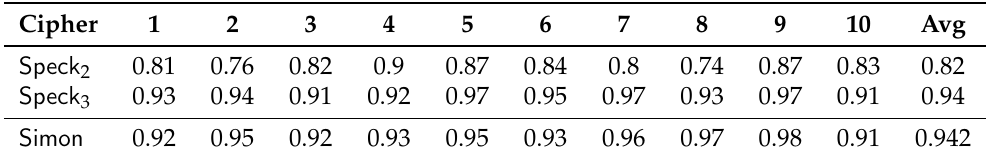
Figure 3. One-shot training and validation accuracy over epochs, for Speck , with a binary cross entropy loss. ( a ) With 200 samples, test accuracy 83%. ( b ) With 300 samples, test accuracy 91%. Table 1. One-shot test accuracies with a binary cross-entropy loss, Speck n indicates “on Speck dataset with 100 ∗ n numbers of